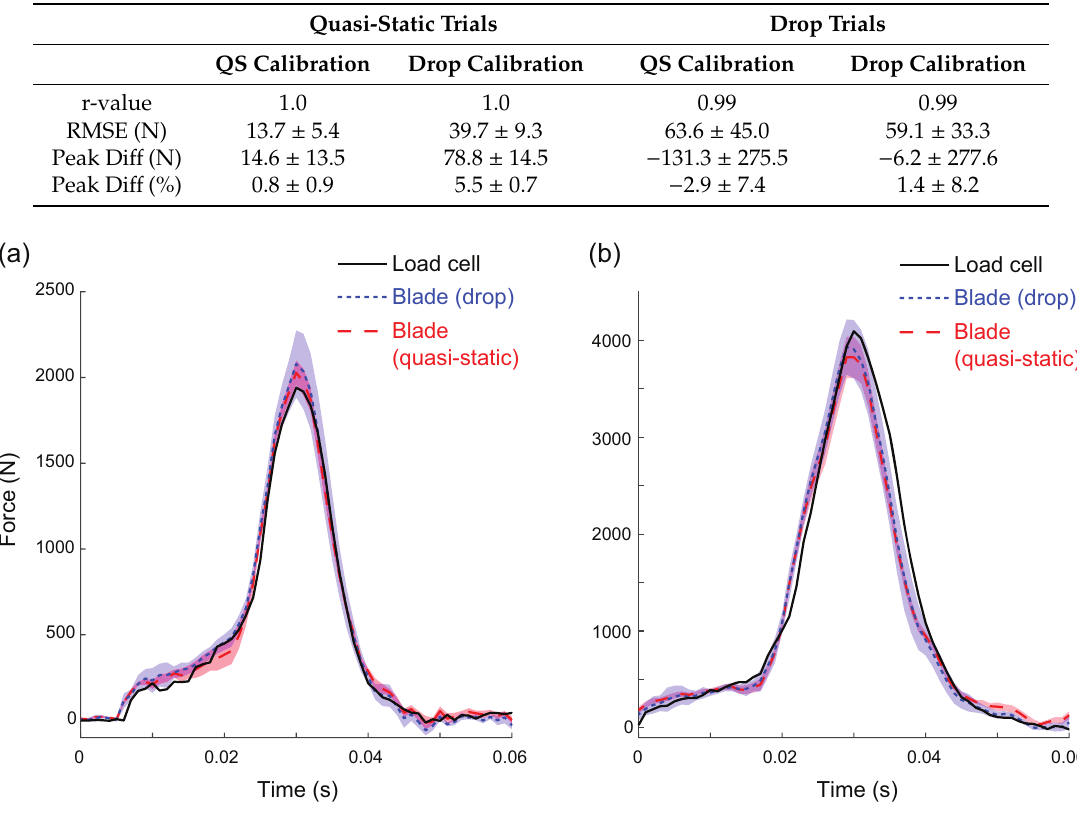
Table 1. Comparison of measured load cell force and calculated blade force using calibrations from two loading conditions (quasi-static versus drop) and one calibration calculation variety (8-in-1-out drop calibration) on nine drop trials (mean ± stdev).